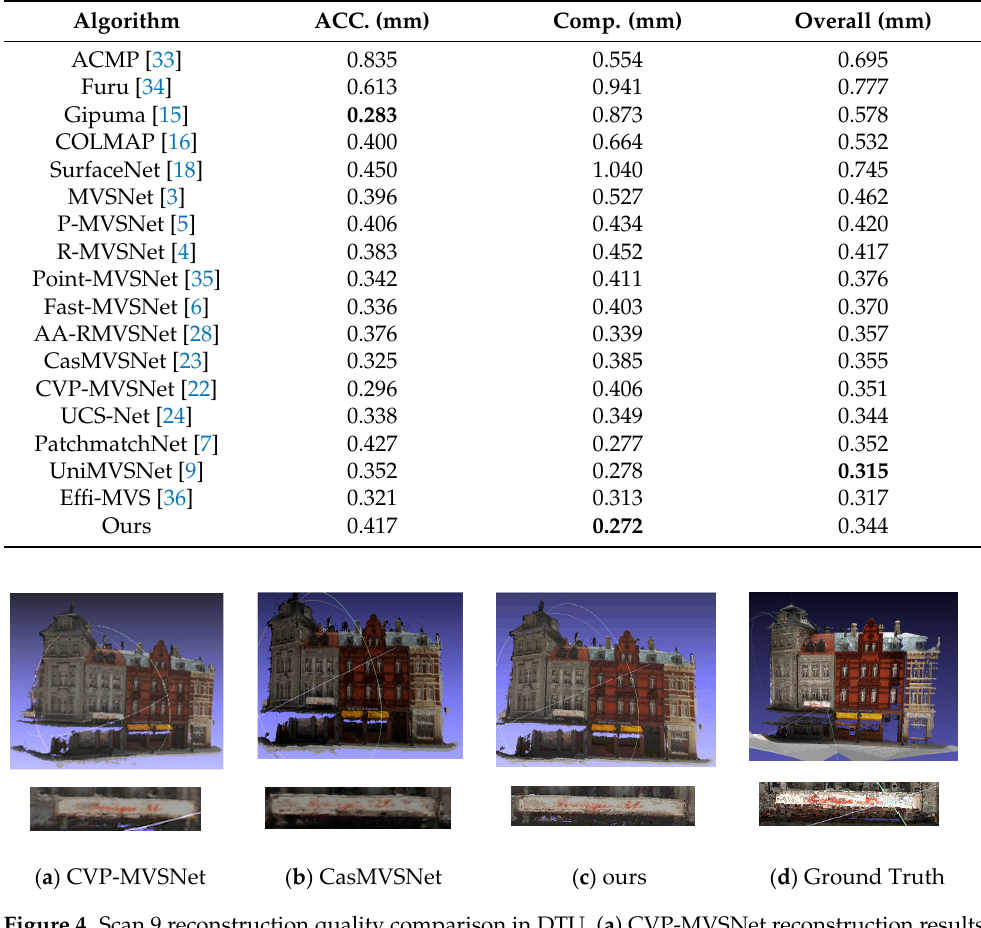
Figure 4. Scan 9 reconstruction quality comparison in DTU. ( a ) CVP ‐ MVSNet reconstruction results. ( b ) CasMVSNet reconstruction results. ( c ) The reconstruction result of our algorithm. ( d ) Real scene in the dataset.